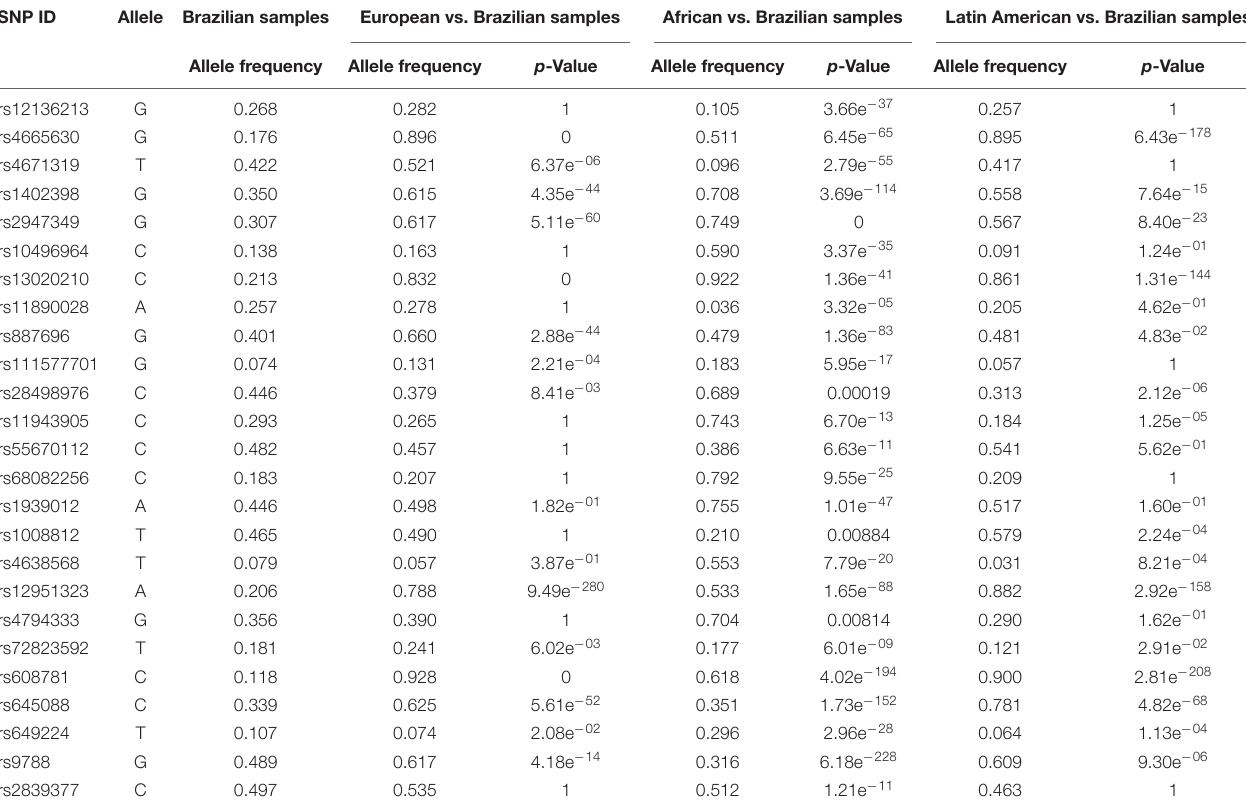
TABLE 4 | Two-proportion Z-test results comparing Brazilian samples with European, African, and Latin-American samples from gnomAD. SNP ID Allele Brazilian samples European vs. Brazilian samples African vs. Brazilian samples Latin American vs. Brazilian